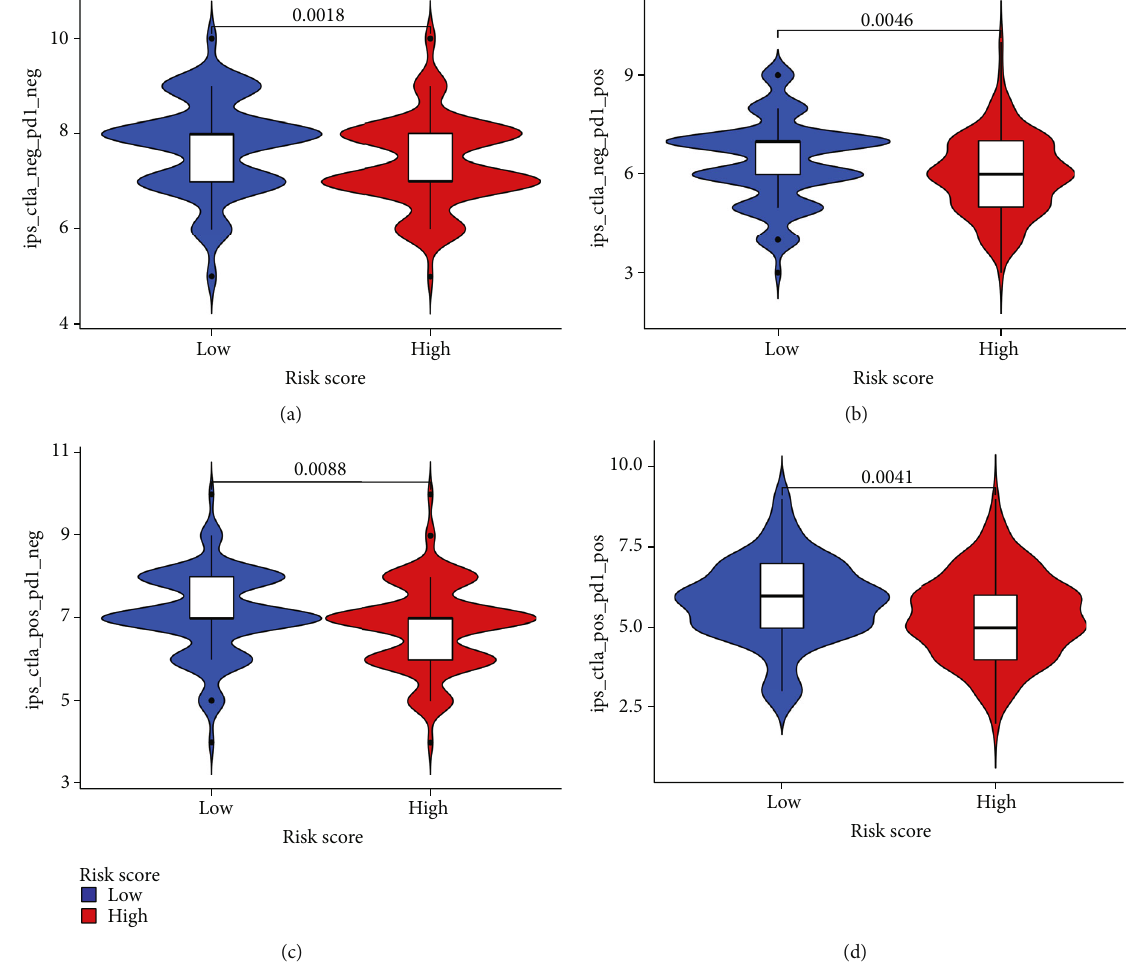
Figure 8: Predictive role of risk scores for di ff erent responses to immunotherapy strategies. (a) Without immunotherapy, high-risk scores resulted in poor prognosis compared with low-risk scores ( p = 0 : 0018 ). (b) If only anti-PD1 immunotherapy was conducted, the group with higher risk scores had a poorer therapeutic e ff ect than the group with lower risk scores ( p = 0 : 0046 ). (c) If only anti-CTLA4 immunotherapy was used, the high-risk group had a worse prognosis compared with the low-risk group ( p = 0 : 0088 ). (d) When anti-PD1 and anti-CTLA4 immunotherapies were used simultaneously, there was a signi fi cantly better prognosis in the low-risk group than in the high-risk group ( p = 0 : 0041